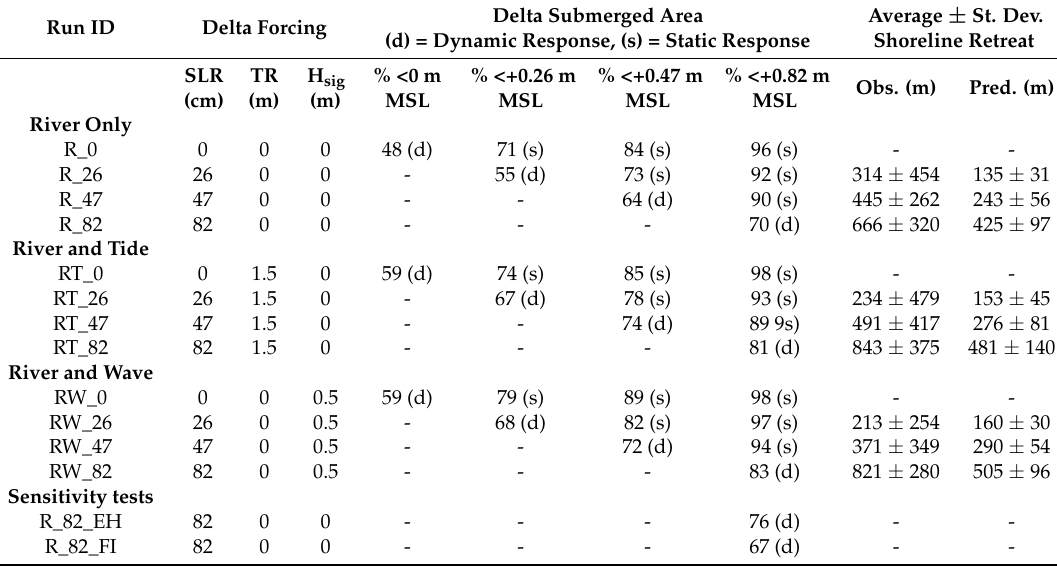
Table 1. Model parameters and descriptive statistics of delta coasts for modeling experiments used in this study. All scenarios use a constant river discharge of 1000 m 3 /s. Observations (“obs”) of shoreline retreat are computed from 19 shore profiles across the modelled deltas, predictions (“pred”) are based on the Bruun (1988) [20] rule applied to the same 19 shore profiles for each modelled delta. Comparisons show a smaller ability to dynamically adjust when using a different sediment transport formulation (R_82_EH), but a greater ability when using finer sediment (R_82_FI). SLR: sea-level rise. TR: tidal range. H sig : significant wave height. St. Dev.: standard deviation. R_82_EH: sensitivity analysis in which the Engelund-Hansen sediment transport formulation is used rather than the Van Rijn formulation. R_82_FI: sensitivity analysis in which a finer sediment of 100 µ m was used rather than the 225 µ m sand in the main